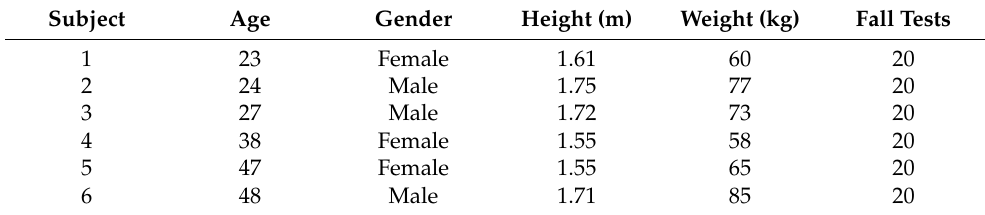
Table 4. Physical characteristics of test